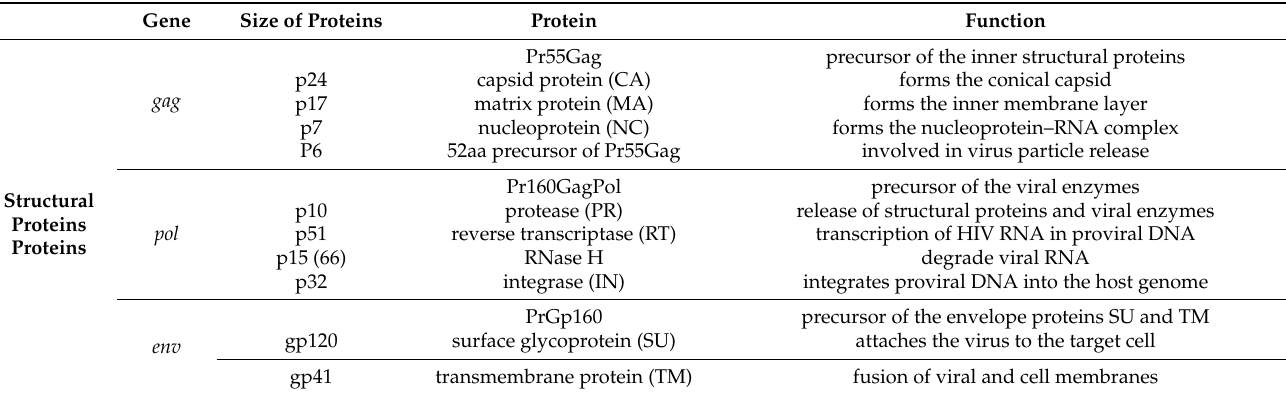
Figure 2. The basic four-generation lentiviral vector plasmid system. The transgene vector is similar for both first- and second-generation lentiviral vectors, while the third-generation lentiviral vectors additionally have a central polypurine tract (cPPT) and woodchuck hepatis virus post-transcriptional response element (WPRE). SIN vectors also replace the U3 region of 3-LTR in both third- and fourth-generation LVs. The packaging vectors differ for the four generations. The first-generation lentiviral vector has all of the accessory genes required for viral replication ( vif , vpr , vpu , and nef ). In contrast, second-generation lentiviral vectors do not have these accessory proteins in their packaging vector. Third-generation LVs do not have the Tat regulatory protein. The fourth generation is differentiated by the split of the gag / pol and rev sequences into two different cassettes. All four systems contain VSV-G as an envelope vector. Table 2. The clinical trials conducted using self-inactivating lentiviral vectors. Table 1. Functions of HIV-1